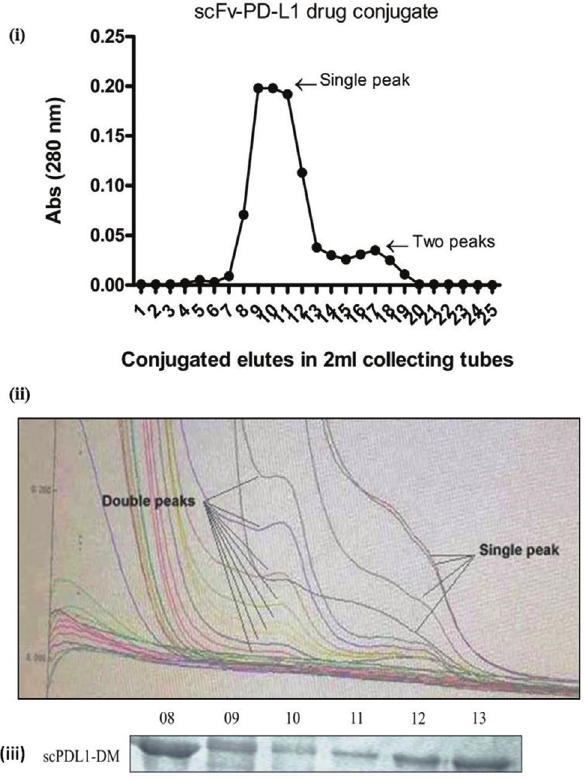
Figure 1 - Spectrophotometry chromatogram peaks absorbance. (i): Absorbance wavelength of scFv-PD-L1 drug conjugates after the Sephadex G-25 column at 280 nm was calculated. A total of 25 tubes were collected after loading and elution with 1X PBS (pH 7.2). The maximum wavelength was found from 8 to 11 with a single peak location. From tubes 12 to 18 the peaks were detected in two different positions. (ii): Av- erage drug to antibody ratios determination from peaks location that indi- cates a single observed location at four different points, may predict drug conjugations with scFv-PD-L1. The double peaks indicate unconjugated drugs. (iii): SDS-PAGE analysis showing results of eluted scPDL1-DM1 drug conjugate after G250 column